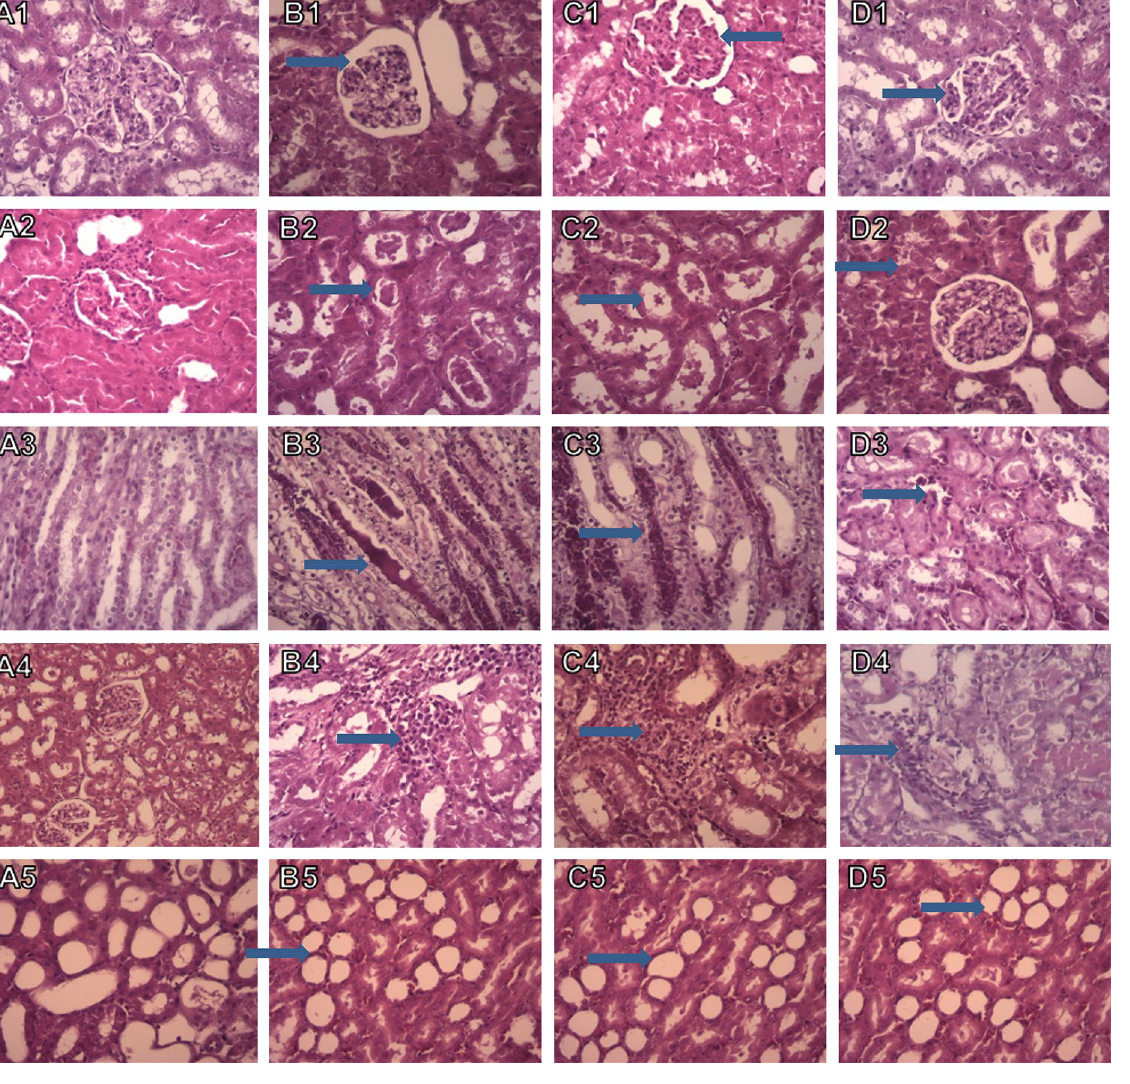
Figure 6. Light photomicrographs of the rats kidney sections (H&E). Kidney sections from control group showed normal renal morphology ( A1 – A5 ). Histological damages after ischemia followed by 1 h of reperfusion including reduction in the size of glomerular tuft, necrosis, medullary vascular congestion and inflammation and cast were observed in I/R ( B1 – B5 ) and I/R empty niosome ( C1 – C5 ) groups. The administration of crocin- loaded nanoniosomes attenuated these damages compared with untreated animals (Magnification